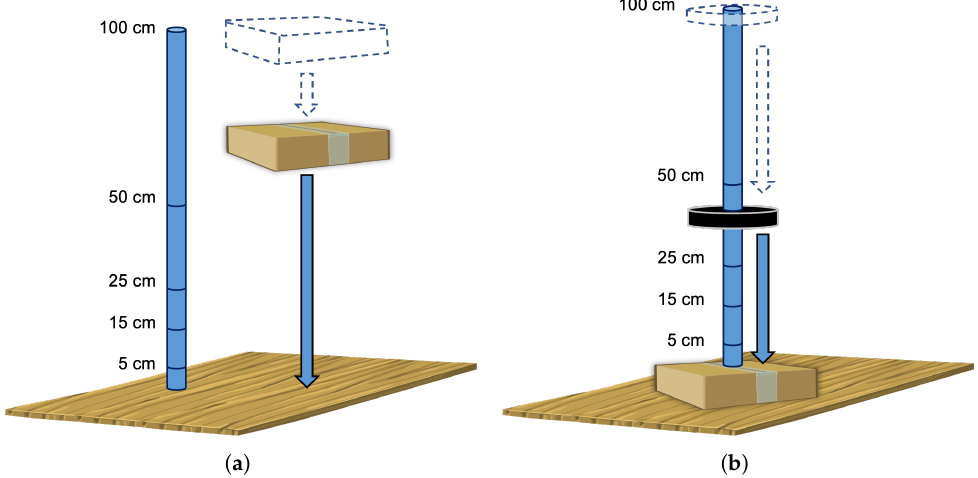
Figure 5. Shock detection test in a laboratory environment: package drop to the floor ( a ); weight drop on the package ( b